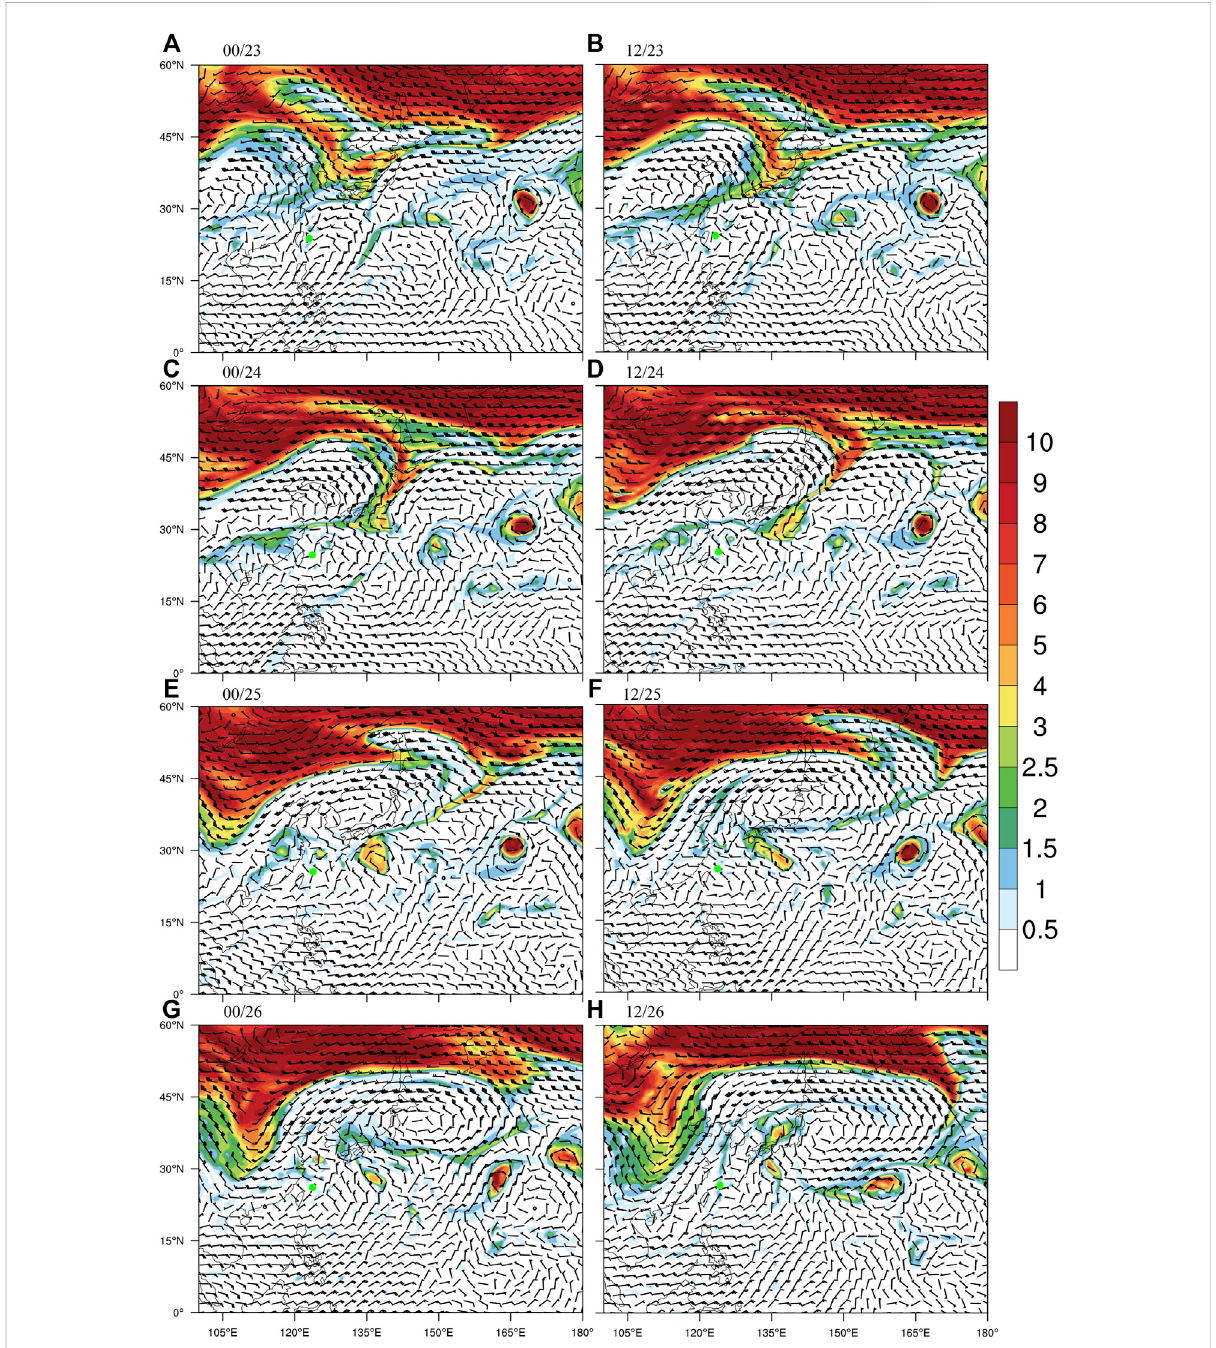
FIGURE 2 200-hPawind barbs (m s − 1 )and potential vorticity (shaded,PVU) based on ERA5 reanalysis data for Typhoon Bavi with 12-h intervals. The green dot indicates the TC center from the JTWC best track